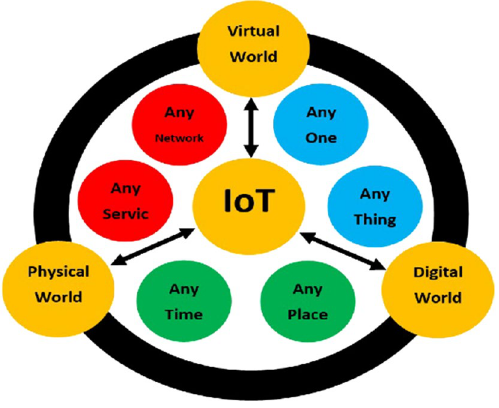
Fig. 2 Processes involved in IoT for fighting Covid-19 in hospital management